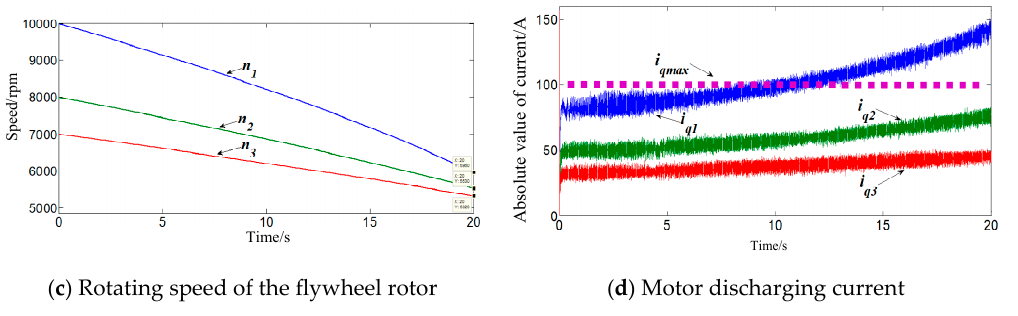
Figure 21. Simulation waveforms of discharging power distributed by residual energy.